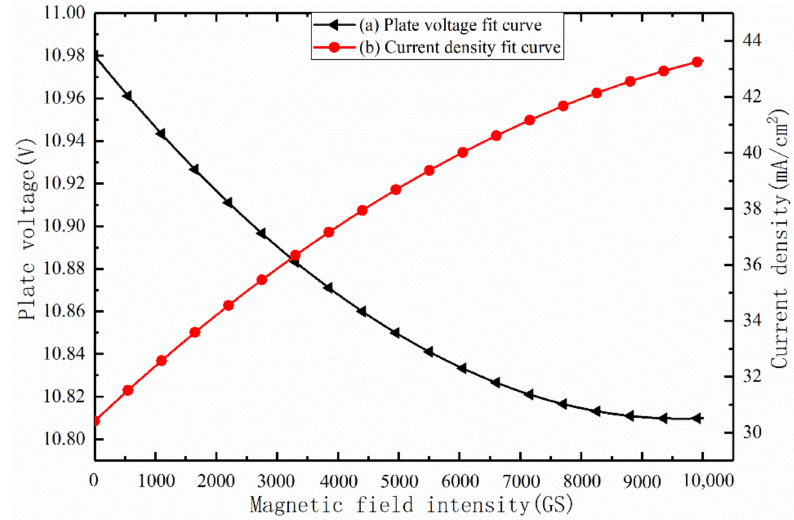
Figure 8. Fitting curves of inter-pole voltage and plate current density in PEM electrolyzer for hydrogen production by electrolysis of distilled water after different magnetic field treatments.